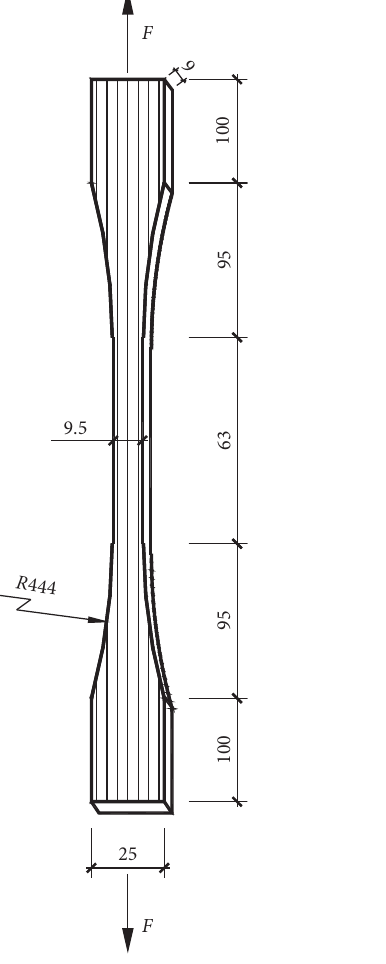
Figure 1: Dimension of tensile specimens (unit: mm).